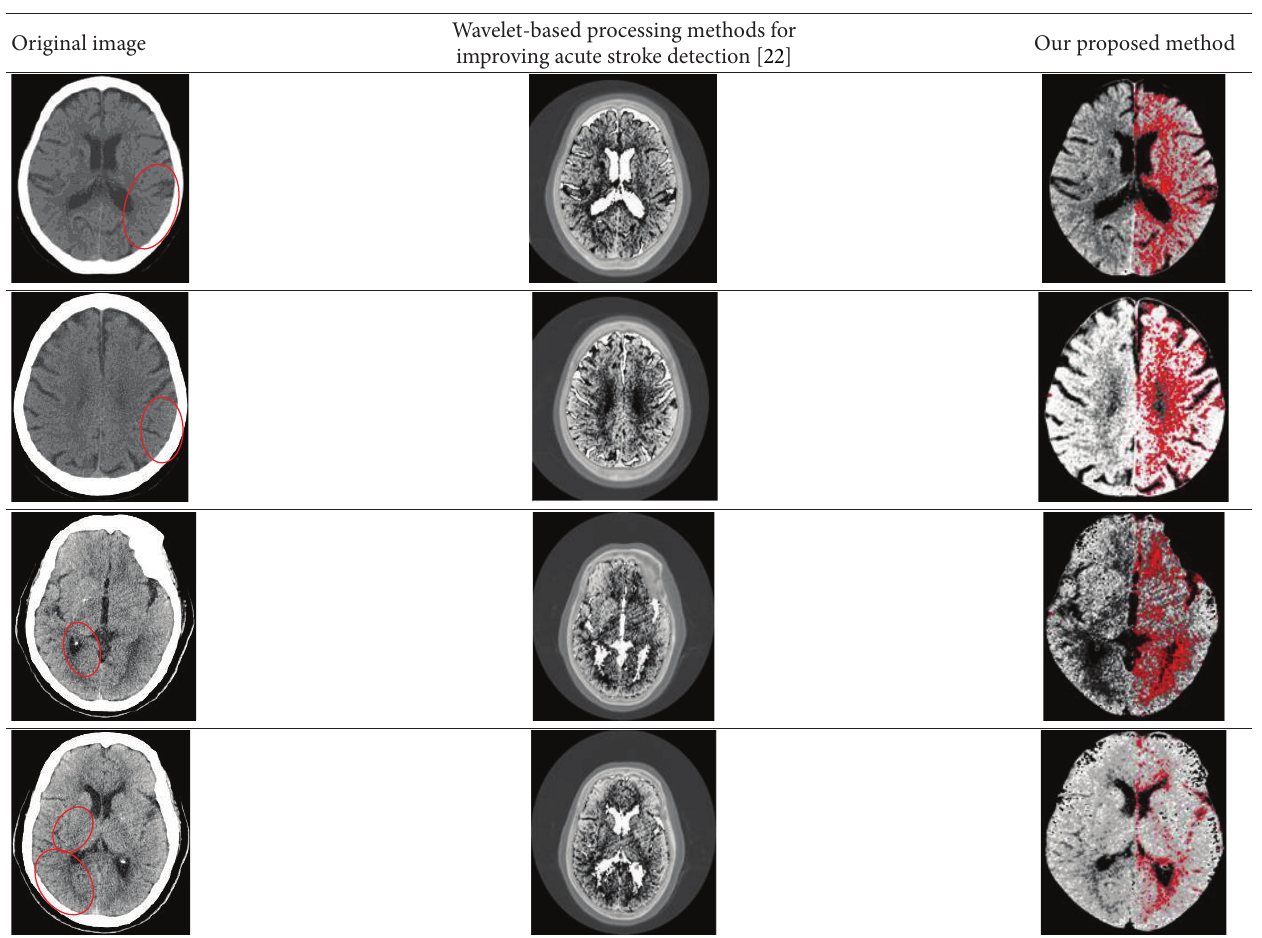
Table 3: Images in failed testing (left-to-right): original image, wavelet-based processing methods for improved acute stroke detection, and increased visual perception brain stroke detection system.